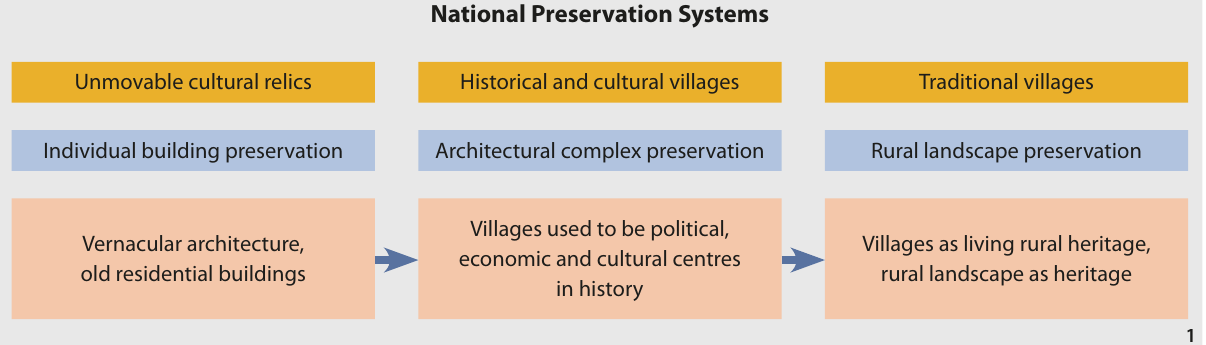
Figure 1 The ideological shift in rural preservation system in China (Source: the